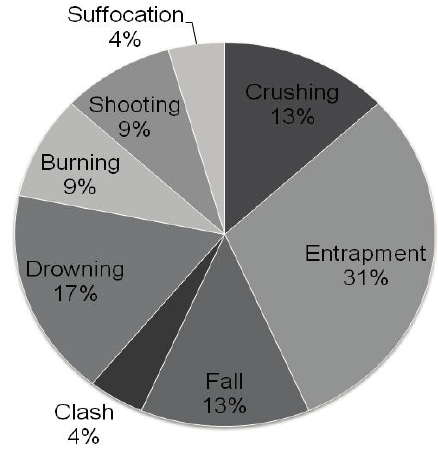
Figure 6. Percentage of injury types recorded in a review of newspaper articles between 9 February 2007 and 11 October 2012 on injuries in small-scale gold mining in